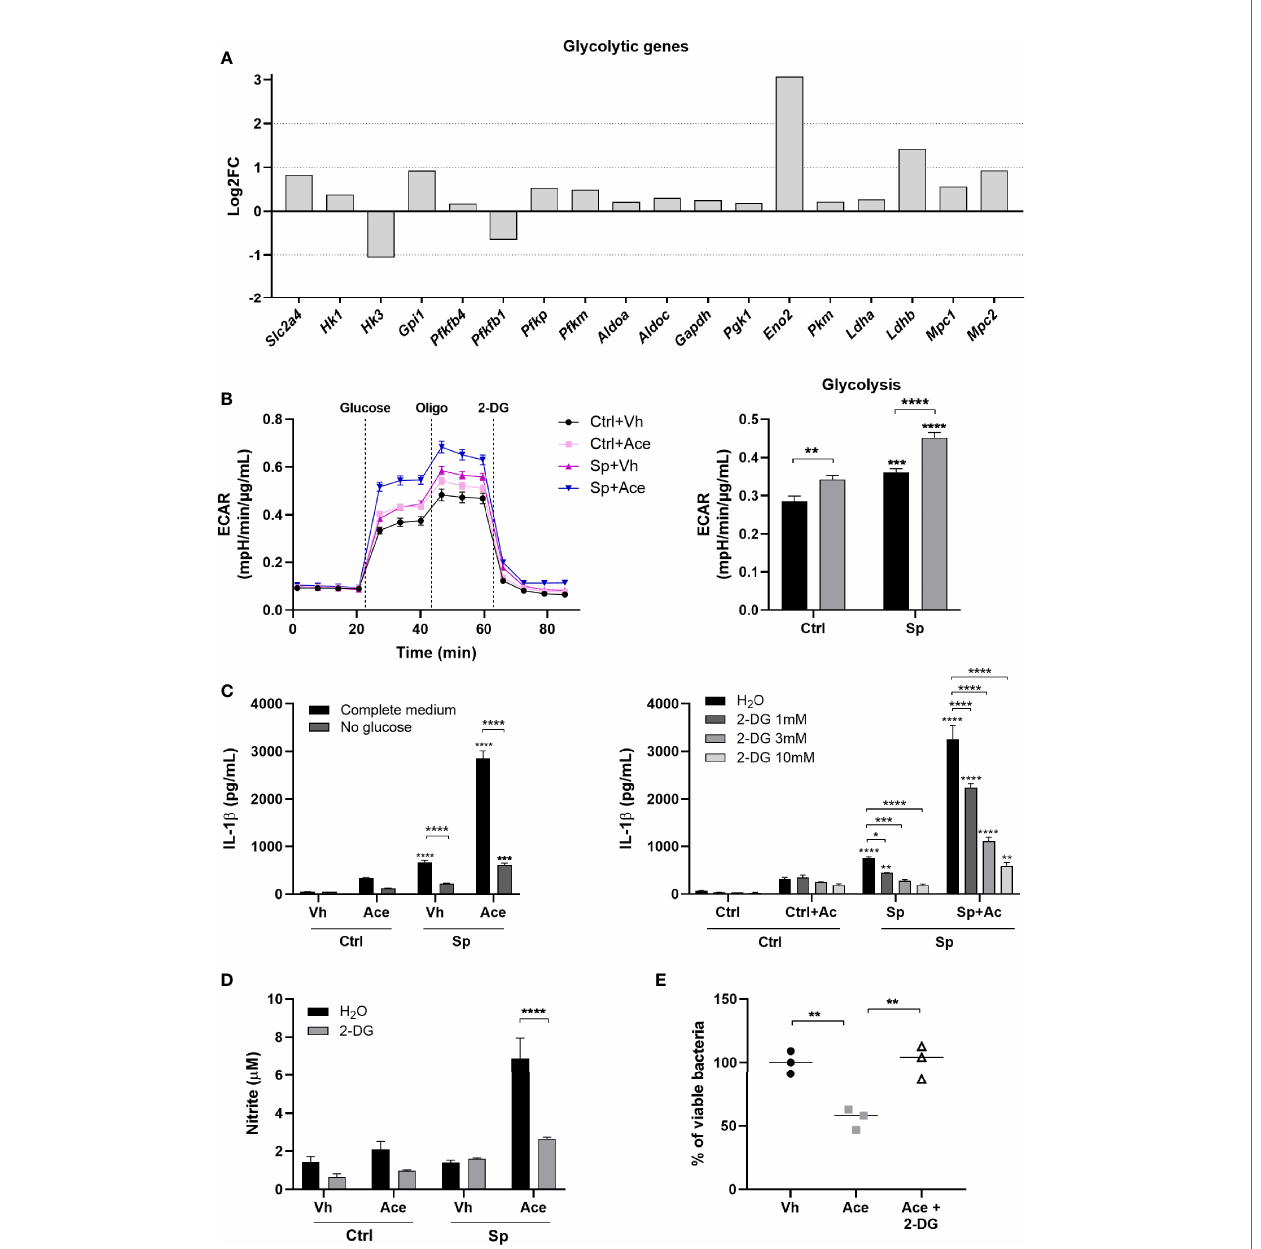
FIGURE 5 | Acetate enhances glycolysis leading to higher IL-1 b production. (A) Log 2 fold change of glycolytic genes expression of acetate treated MPI cells stimulated with S. pneumoniae over vehicle treated cells stimulated with S. pneumoniae . Data were obtained from RNA-Seq. All represented genes had p < 0.01 in the comparison between the two groups. Solute carrier family 2, facilitated glucose transporter member 4 ( Slc2a4 ), hexokinase ( Hk1, Hk3 ), glucose-6-phosphate isomerase ( Gpi1 ), 6-phosphofructo-2-kinase ( Pfkfb4, Pfkfb1 ), ATP-dependent 6-phosphofructokinase platelet and muscle types ( Pfkp , Pfkm ), fructose-bisphosphate aldolase ( Aldoa, Aldoc ), glyceraldehyde-3-phosphate dehydrogenase ( Gapdh ), phosphoglycerate kinase 1 ( Pgk1 ), gamma-enolase ( Eno2 ), ( Pkm ), L-lactate dehydrogenase ( Ldha, Ldhb ), mitochondrial pyruvate carrier ( Mpc1, Mpc2 ). (B) Glycolysis stress assay of MPI cells pre-treated or not with acetate, and then stimulated or not with S. pneumoniae for 24 h. ECAR was measured in Seahorse after injection of glucose, oligomycin (Oligo) and 2-Deoxy-D-glucose (2-DG) ( right panel ). Glycolysis was calculated by the subtraction of the highest measure after glucose injection by the last basal measure, for each group ( left panel ). (C) ELISA for IL-1 b from supernatant of MPI cells pre-treated or not with acetate in the presence or not of glucose ( left panel ) or 2-DG ( right panel ) and then stimulated or not with S. pneumoniae for 24 h. (D) Nitrite concentration assessed by Griess assay from supernatant of MPI cells pre-treated or not with acetate in the presence of absence of 2-DG 10 mM and stimulated or not with S. pneumoniae during 48 h. (E) % of intracellular viable bacteria left 6 h post infection of activated MPI cells treated or not with acetate and/or 2-DG 10 mM, normalized to vehicle group. Lines/bars showing the mean and error showing the SEM of sextuplicates (B) or triplicates (C, D) and data showing the median of triplicates (E) . Results are representative of three independent experiments. Statistical analysis was done using Two-way ANOVA (B, C) and One-Way ANOVA (E) corrected with Sidak ’ s multiple comparisons test (*p < 0.05, **p < 0.01, ***p < 0.001, ****p <